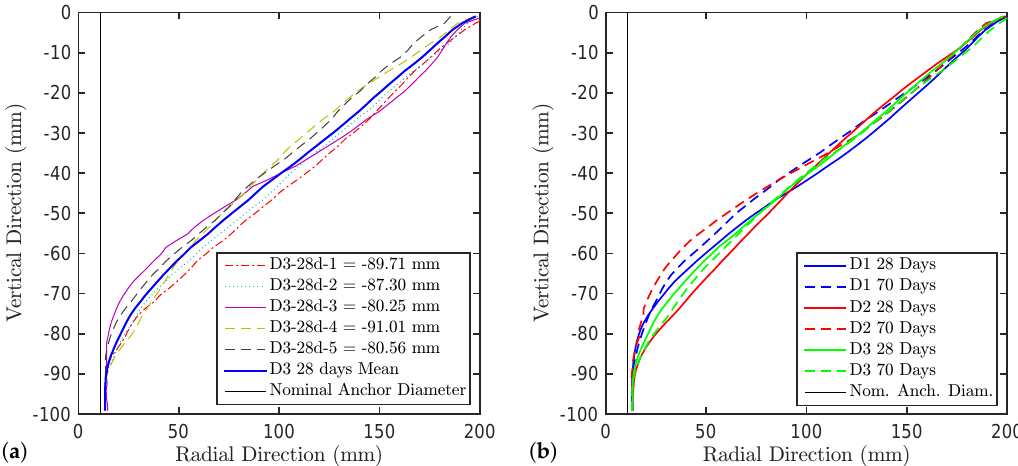
Figure 3. ( a ) Mean profiles of the craters of D3 at 28 days and their mean, and ( b ) comparison of the mean crater profiles of the different batches and different